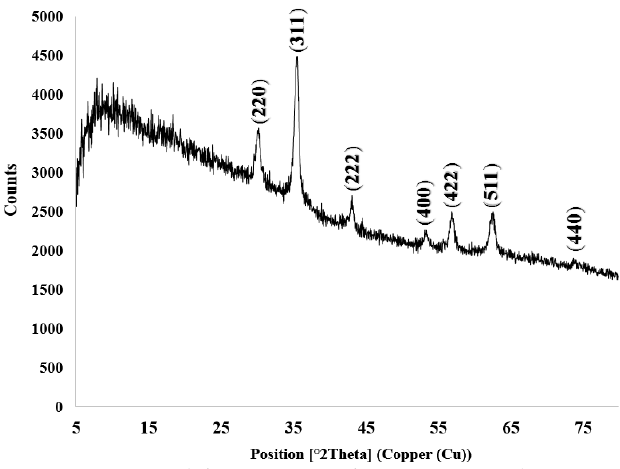
Fig. 3. X-ray diffraction patterns of ZnFe Figure 3 : X-ray diffraction patterns of ZnFe 2 O 4 nanoparticles